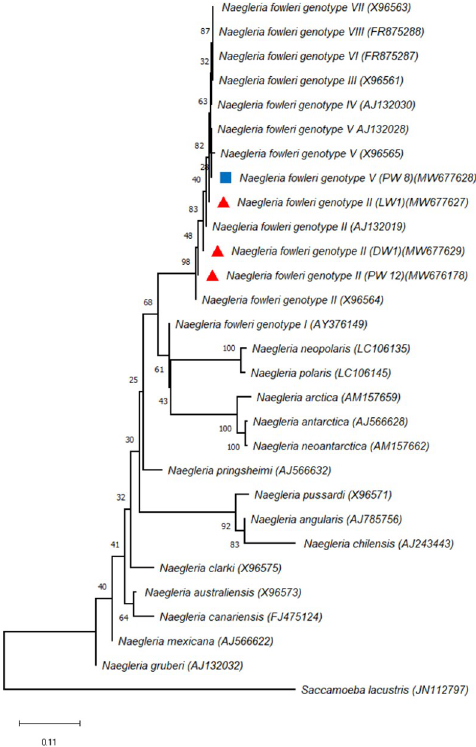
Fig 6. Phylogenetic tree of Naegleria isolates for the ITS sequences. Phylogenetic tree inferred using neighbor- joining cluster analysis of the sequence obtained and the sequences from ITS1, 5.8S rRNA and ITS2 sequences of various Naegleria strains, with special reference to N . fowleri produced in MEGA X. Bootstrap values are based on 1000